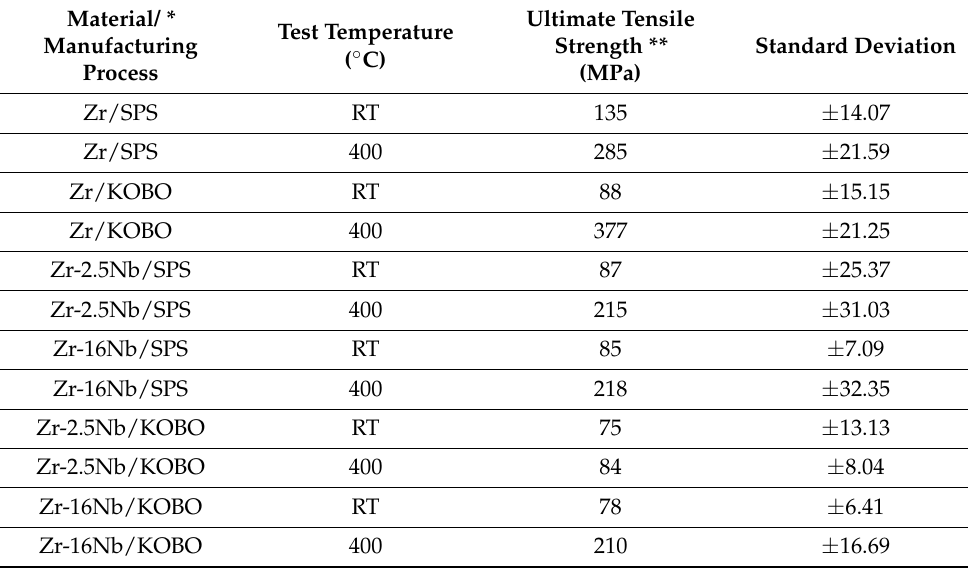
Figure 8. Tensile stress-strain curves of the sintered Zr-2.5 mass% Nb, Zr-16 mass% Nb and Zr materials; tests were carried at 400 ◦ C. Table 6. Ultimate tensile strengths for sintered and extruded Zr-xNb